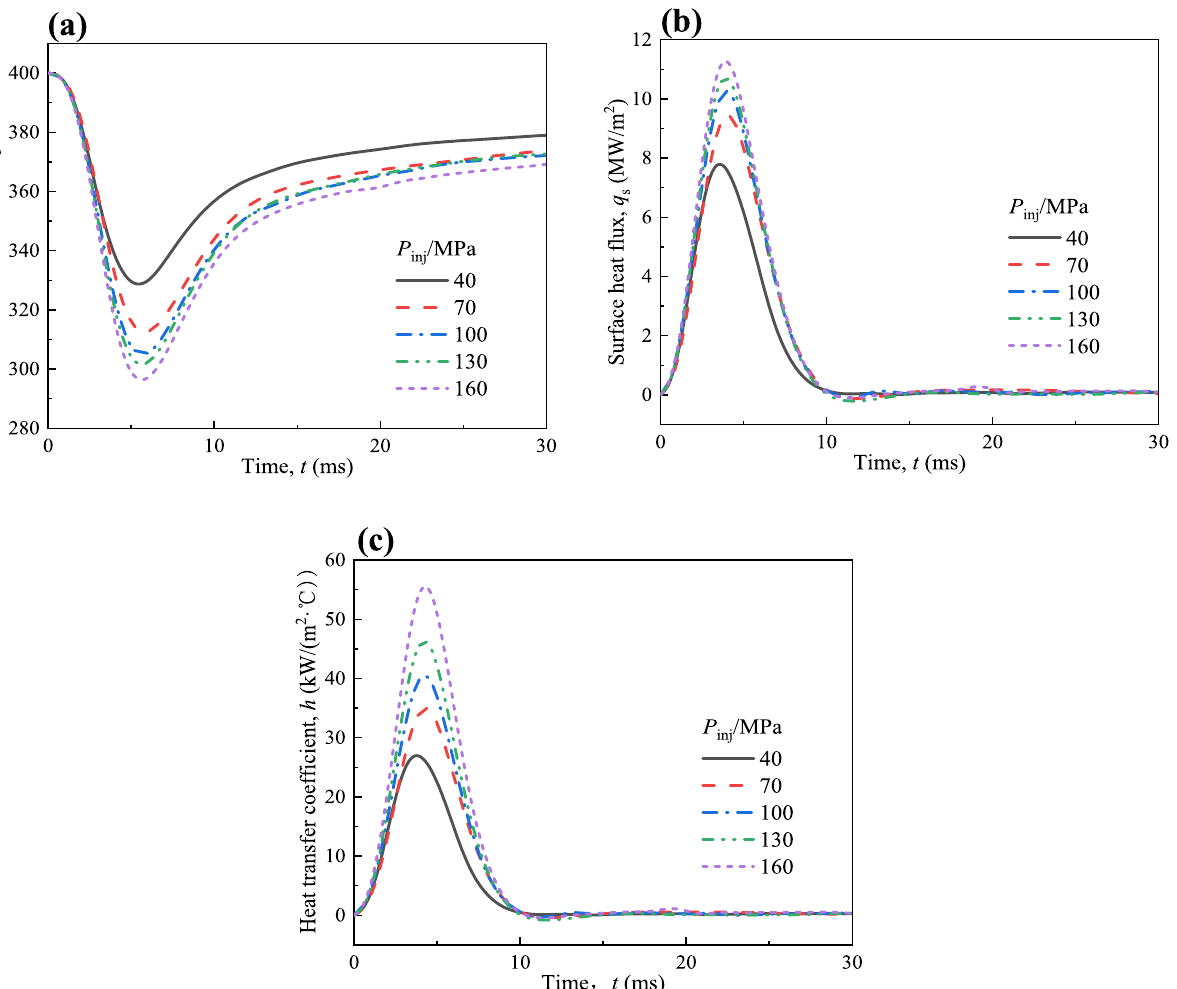
Figure 5. Variations of ( a ) T s , ( b ) q s and ( c ) h at different P inj with spray-wall impingement for T init = 400 °C and T amb = 80